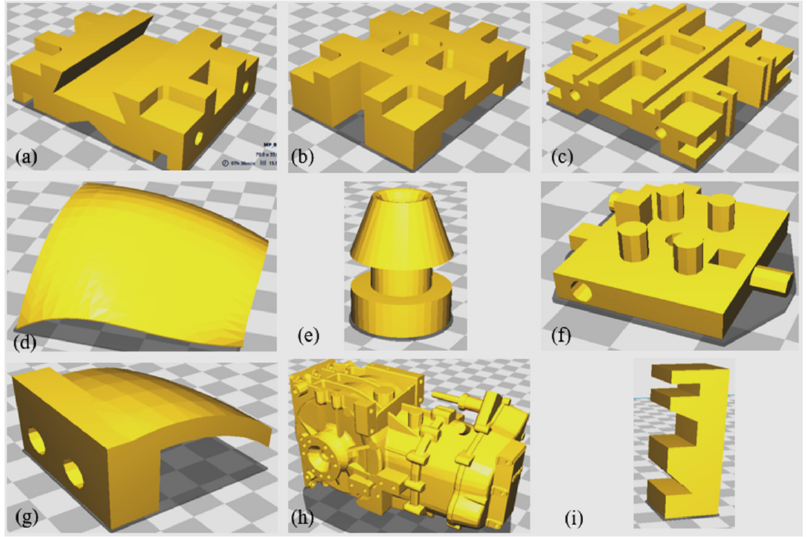
Figure 5. Case Studies ( a ) Component 1; ( b ) Component 2; ( c ) Component 3; ( d ) Component 4;